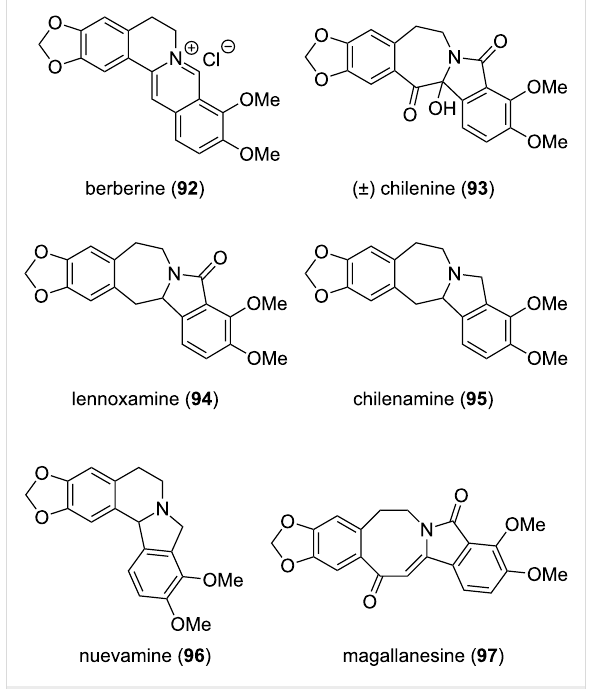
Figure 6: Representative Berberis